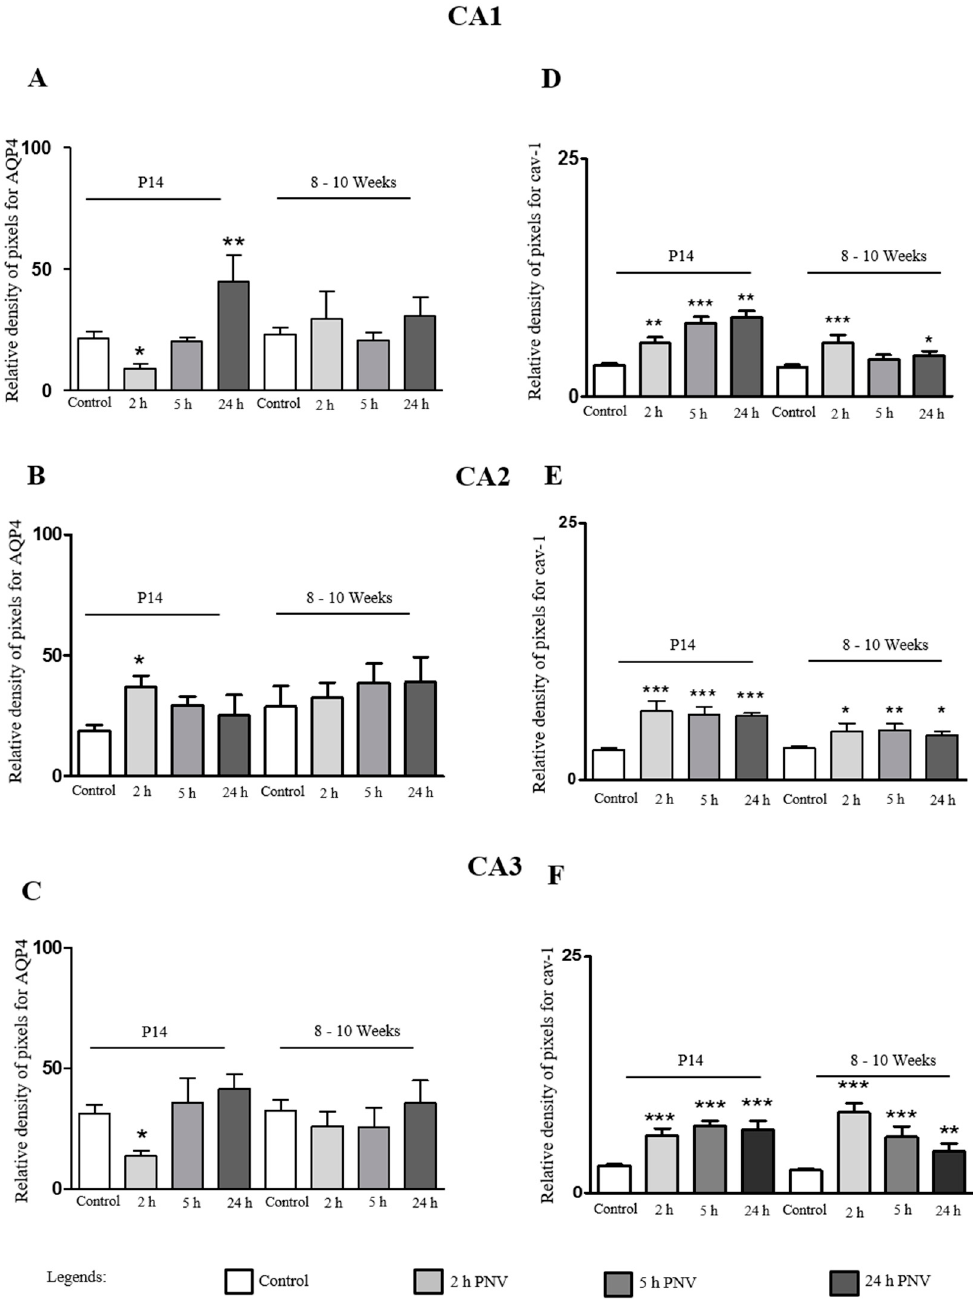
Figure 3. Percentage of pixels density of aquaporin-4 (APQ4) and caveolin-1 (Cav-1) labeled cells after PNV or 0.9% saline injection; immunohistochemistry of AQP4 and Cav-1 was computer-treated in order to segment by labeling color the immunoreactive sites of each protein through the use of GIMP 2.6.4 software. ( A – C ) Graphs of neonates and adults for AQP4 protein expression after envenoming in CA1, CA2 and CA3 hippocampal subfields; ( D – F ) Graphs of neonates and adult rats for Cav-1 expression after envenoming in CA1, CA2 and CA3. * p < 0.05, ** p < 0.01 and *** p < 0.001 compared to the saline control (Student’s t -test of data expressed as mean ± SEM); n = 10 images per subfield, per treatment, per time-point.